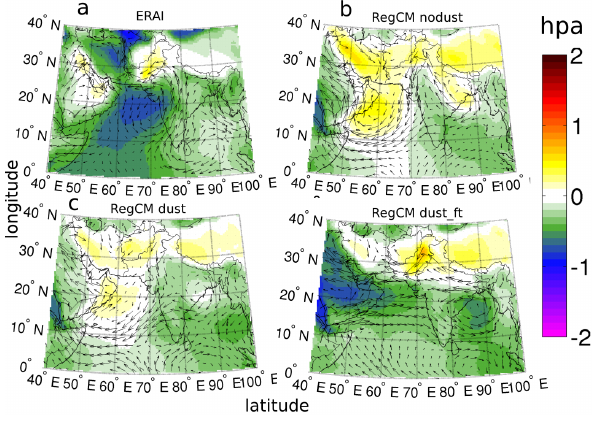
Figure 4. Difference of mean JJAS 850hpa circulation and surface pressure between DUSTY (2005–2009) and NONDUSTY (2000– 2004) pentads as defined in the text and calculated from (a) ERAI reanalysis, (b) “ nodust ” simulations, (c) “ dust ” standard simula- tions and (d) “ dust _ ft ” simulations with forced emission trend over Arabia. As a complement to ERAI, an equivalent graph has been produced from NCEP reanalyses and displayed in Fig. S1 in the Supplement. All simulated results represent a three-ensemble- member mean.